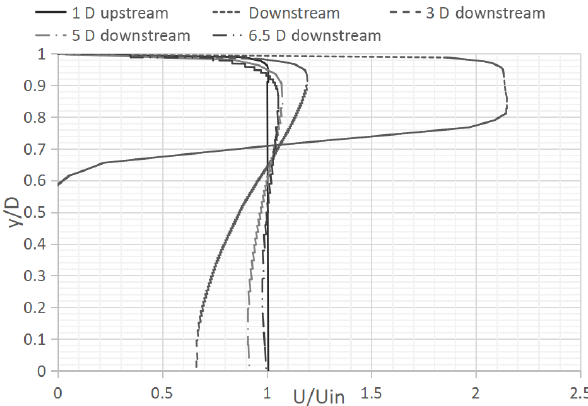
Figure 21. Velocity profiles at different axial positions, P-G cone.